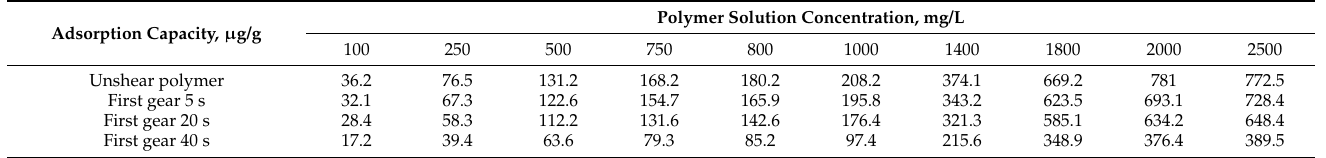
Table 1. Effect of Shear on the Static Adsorption Capacity of the Polymer.